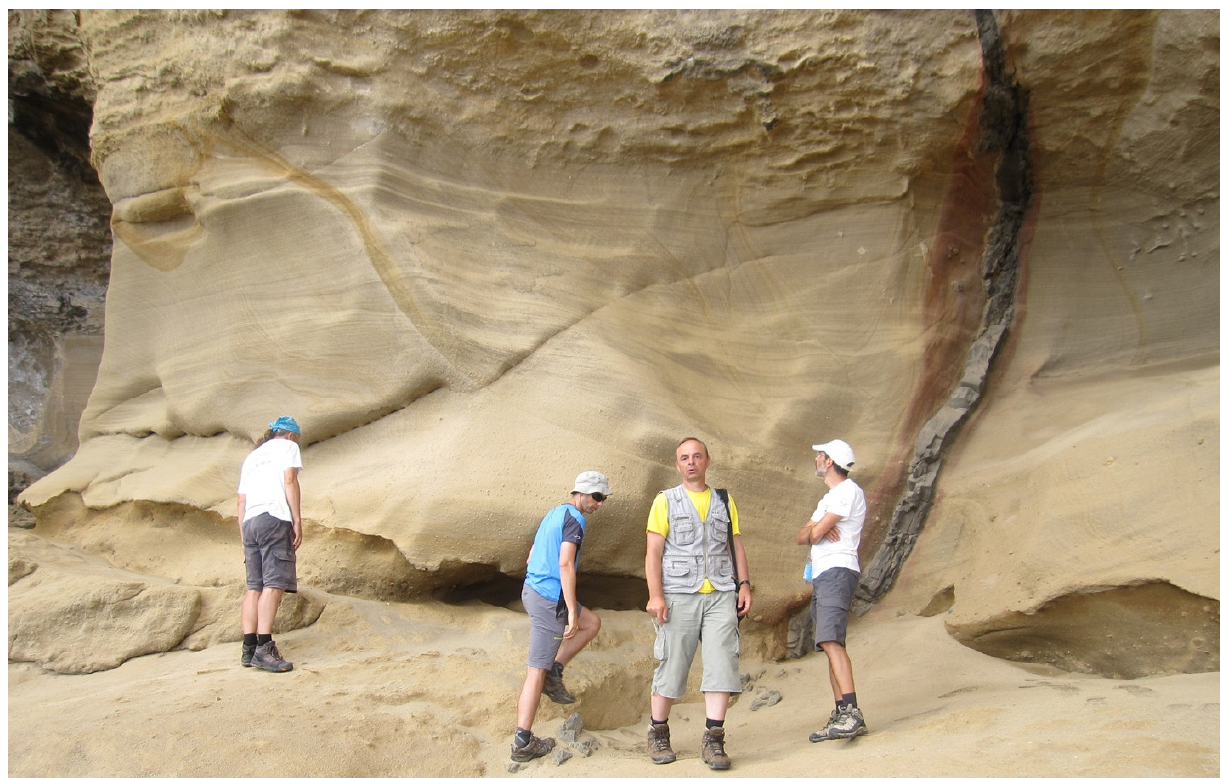
Figure 9. Storm deposit from the Lower Pliocene represented by a singular 5-m thick sandstone body that washed over a low-relief rocky shore at Malbusca on the south coast of Santa Maria Island in the Azores [60].